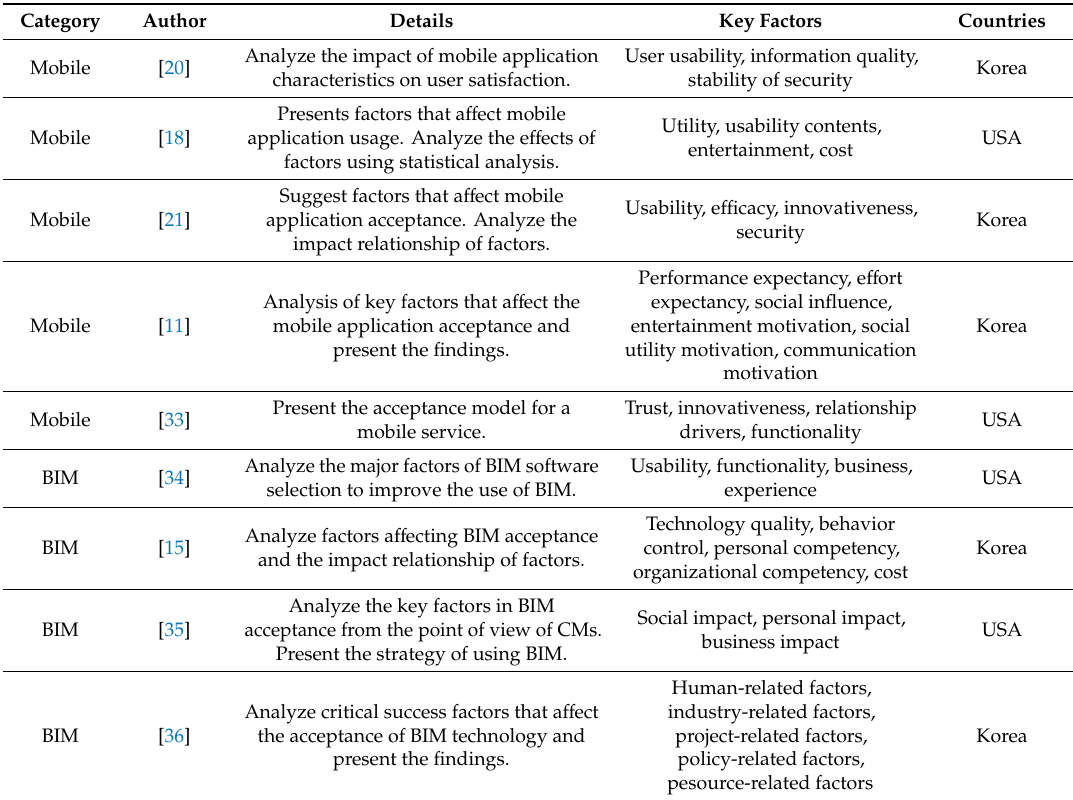
Table 2. Literature Reviews on key factor for Mobile-BIM